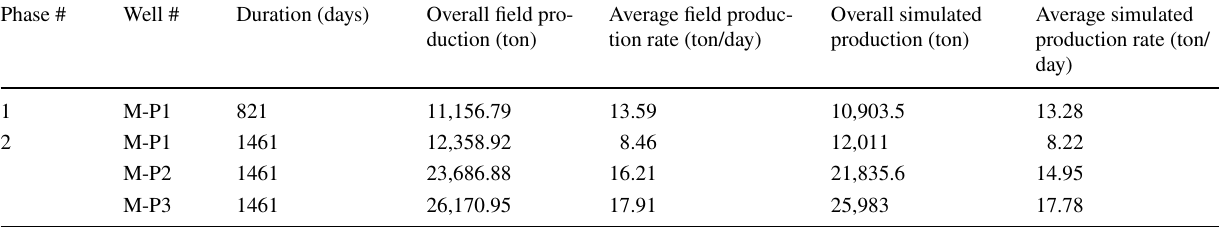
Table 4 The production history of the side well and the two parent wells